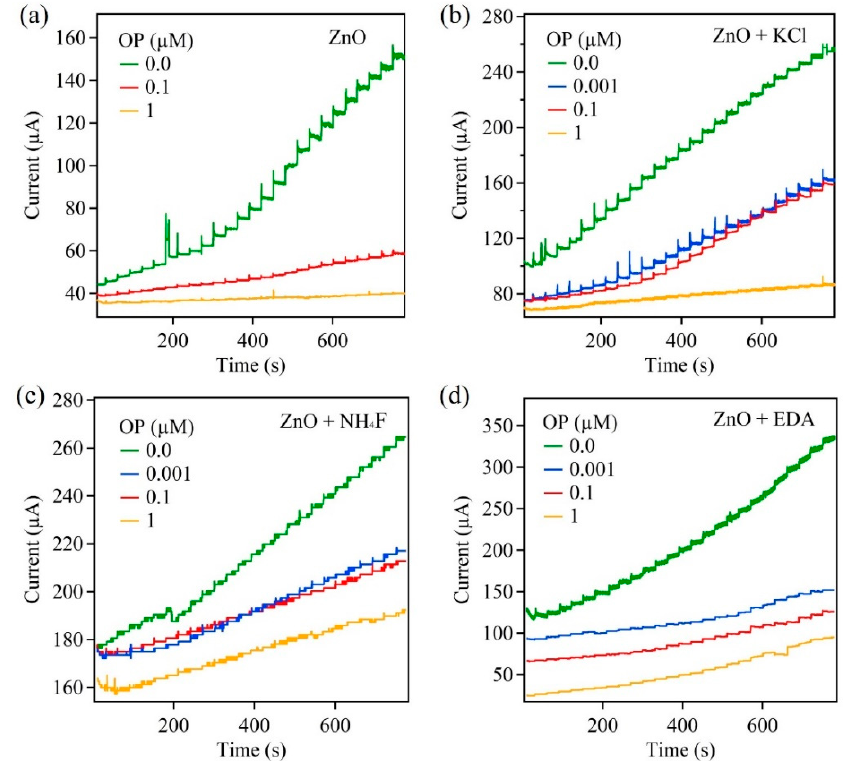
Figure 3. Amperometric response of ZnO samples on carbon paper: ( a ) ZnO, ( b ) ZnO + KCl, ( c ) ZnO + NH ₄ F, and ( d ) ZnO + EDA.